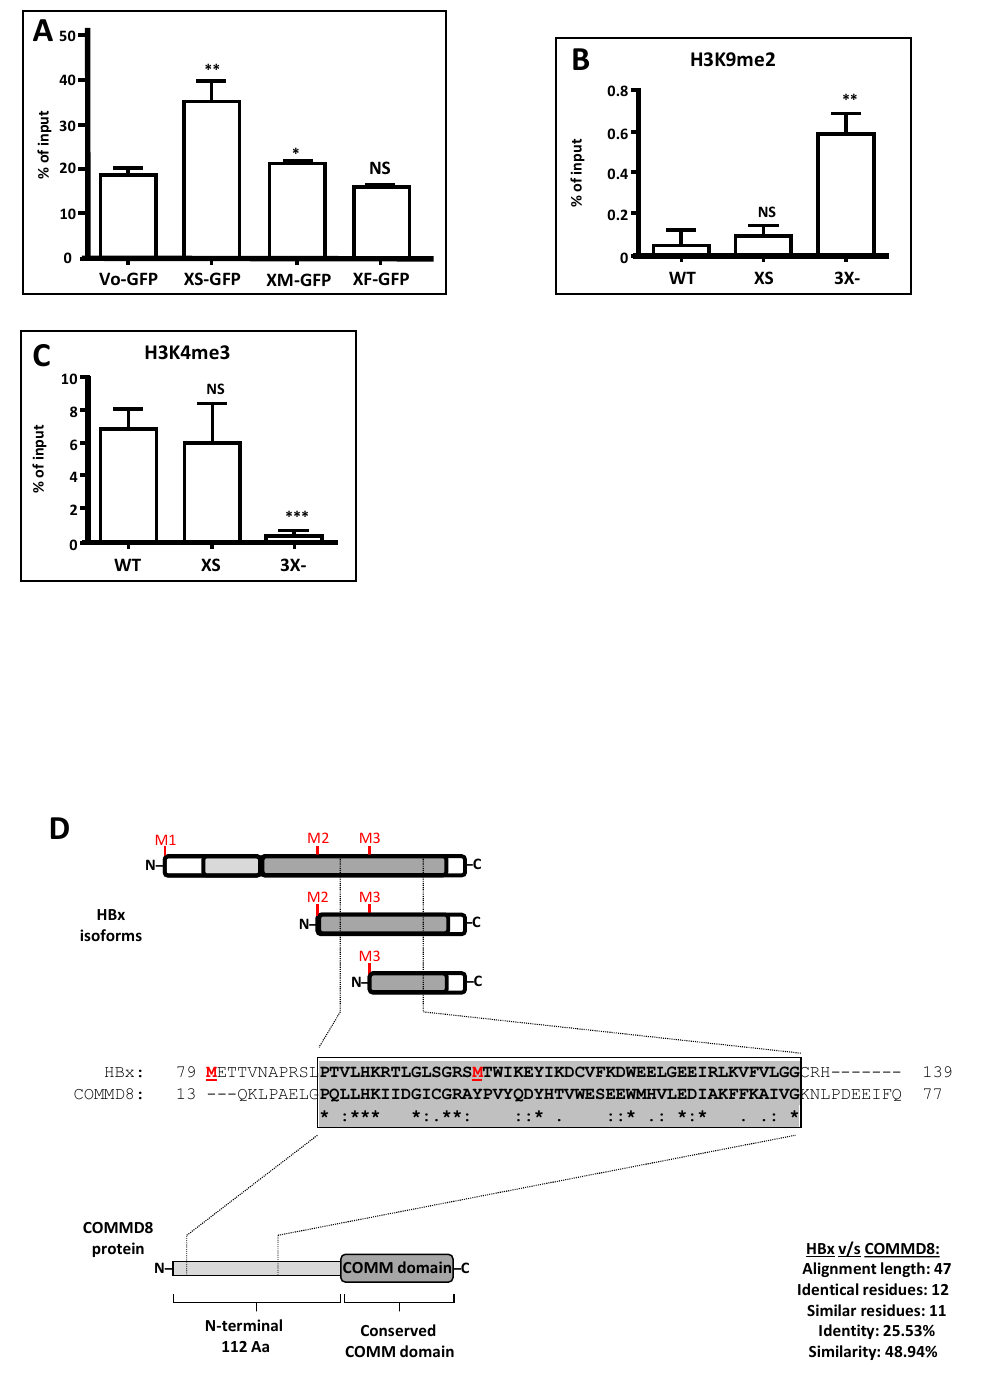
Figure 4. Roles and properties of the HBx XM and XS smaller isoforms. ( A ) The HBV XS isoform binds to the cccDNA and is sufficient to establish an active viral chromatin state. HepG2 cells were co-transfected with WT HBV DNA and one of the constructs, GFP-Vo (GFP empty vector), HBx XS-GFP, HBx XM-GFP or HBx XF-GFP, and the cells were analyzed by chromatin immunoprecipitation (ChIP) assays. HBx isoform binding to cccDNA was determined by ChIP analysis using GFP-conjugated Sepharose beads. Immunoprecipitated DNA was quantified by qPCR using specific primers for the core promoter. The results are expressed as % of input. The standard deviation was obtained from three PCR reactions, and the graphs are representative of three independent experiments. *: p < 0.05, **: p < 0.01, ***: p < 0.001, Student’s t -test. ( B , C ) Analysis of post-translational modifications of histones bound to the core viral promoter by ChIP. HepG2 cells were transfected with the viral full constructs, either WT HBV, HBV XS, or HBV 3X- genomes, and cells were analyzed 72 h later for ChIP assay. Covalent post-translational modifications on histone H3 were determined using specific antibodies H3K9me2 ( B ) and H3K4me3 ( C ). Immunoprecipitated DNA was quantified by qPCR using specific primers for the core promoter.